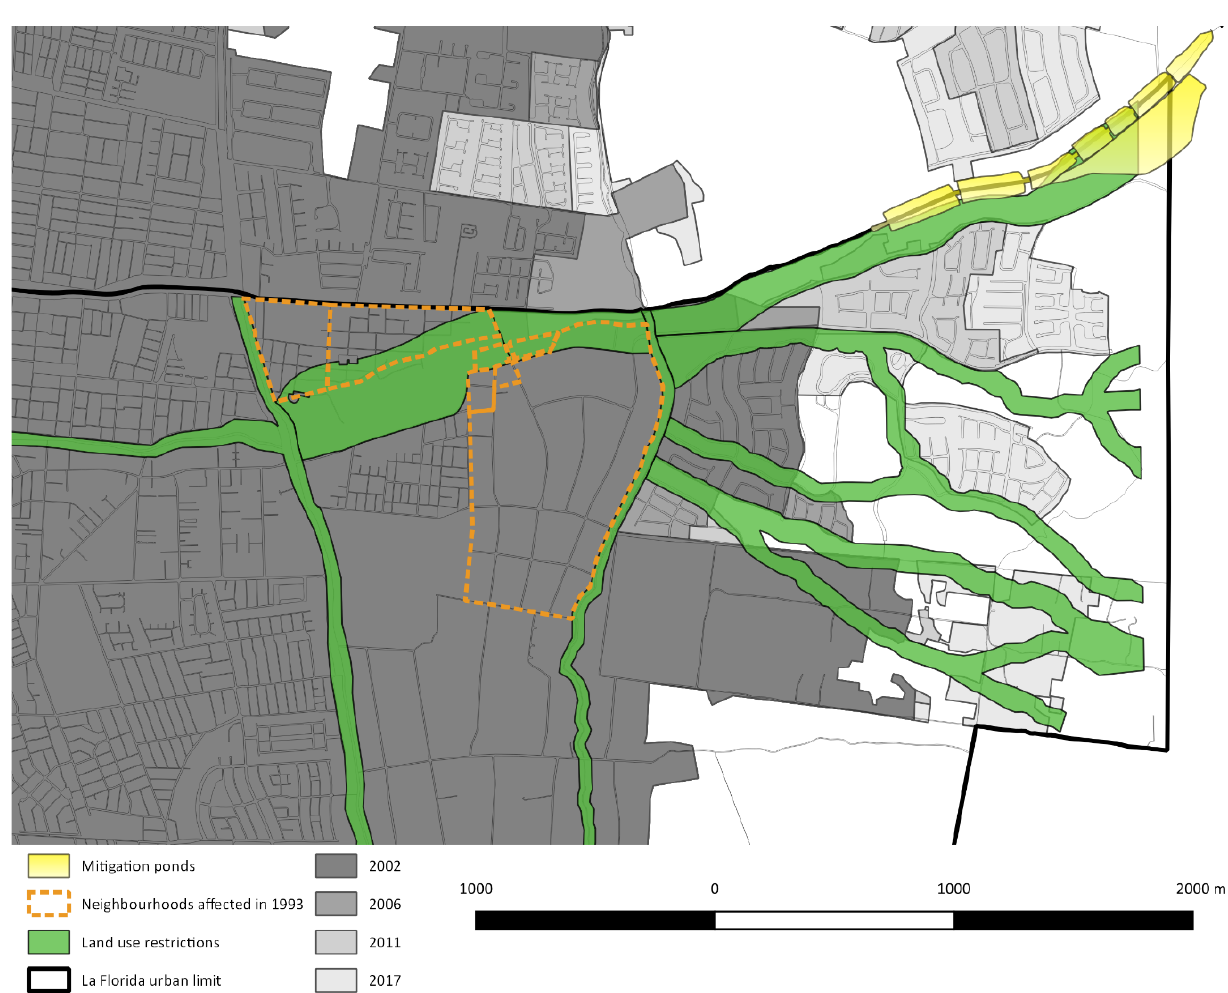
Figure 3. Development and risk management in Santiago’s Foothills (1993–2017). Source: Authors based on